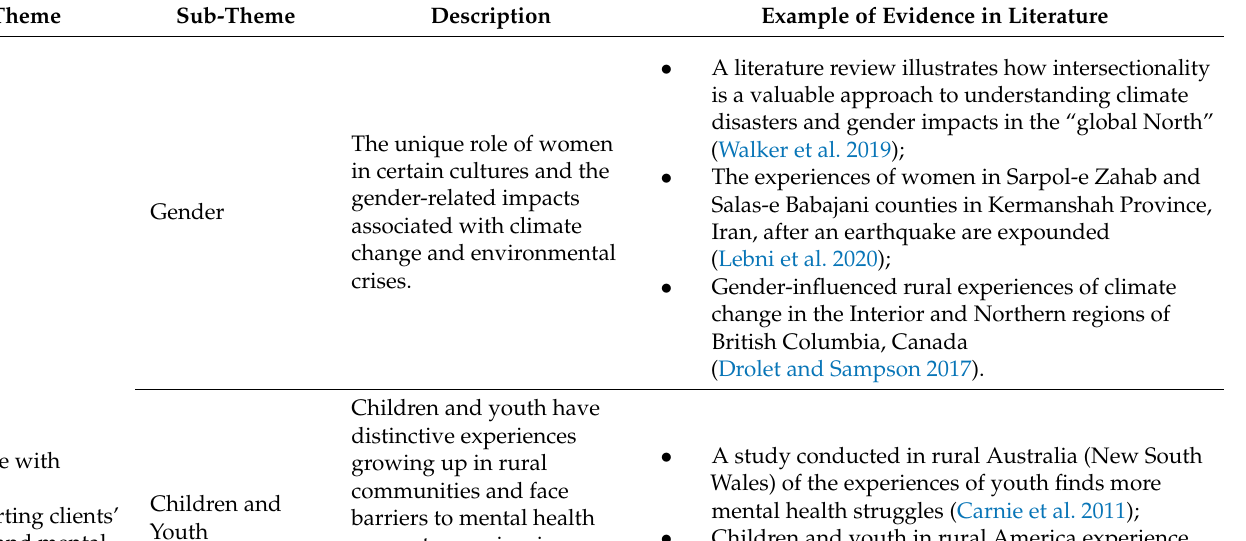
Table 2. General Theme and